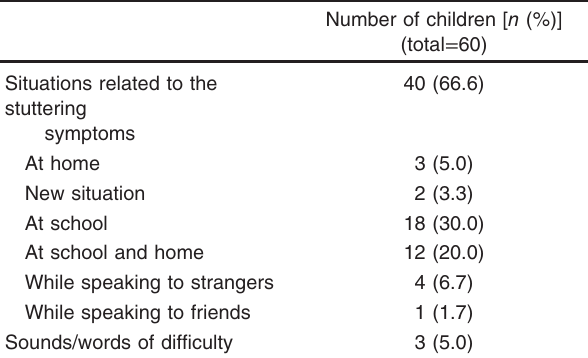
Table 3 Symptoms of stuttering related to a special situation and/or to a specific spoken sound and/or word